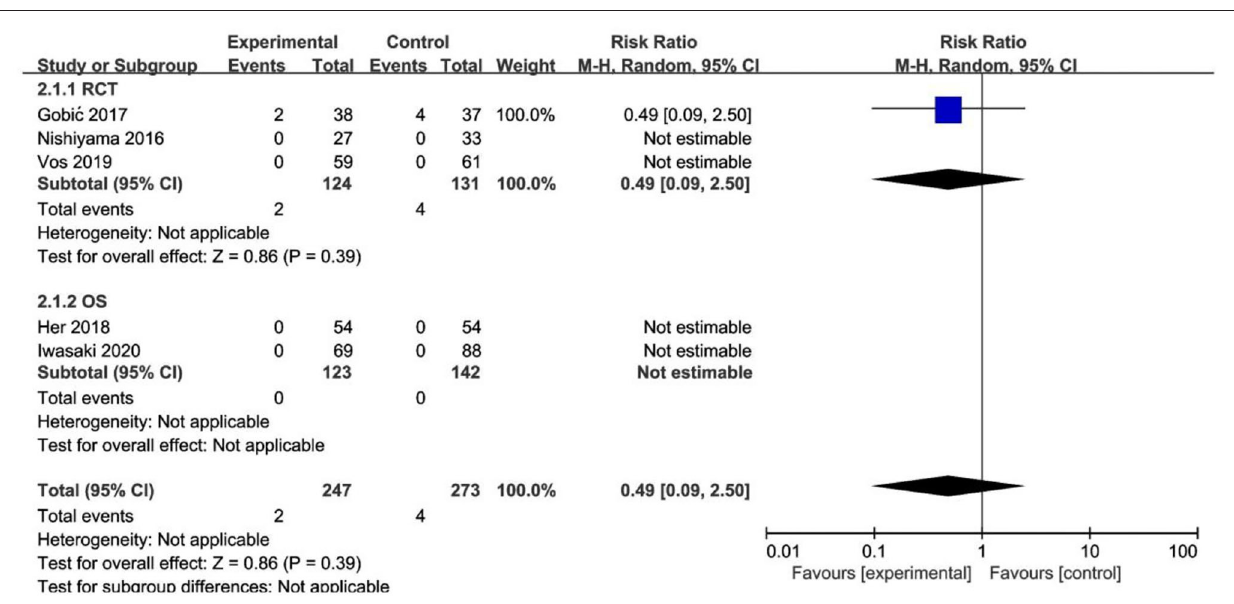
FIGURE 5 | Meta-analysis of the effects of DCB compared with control in